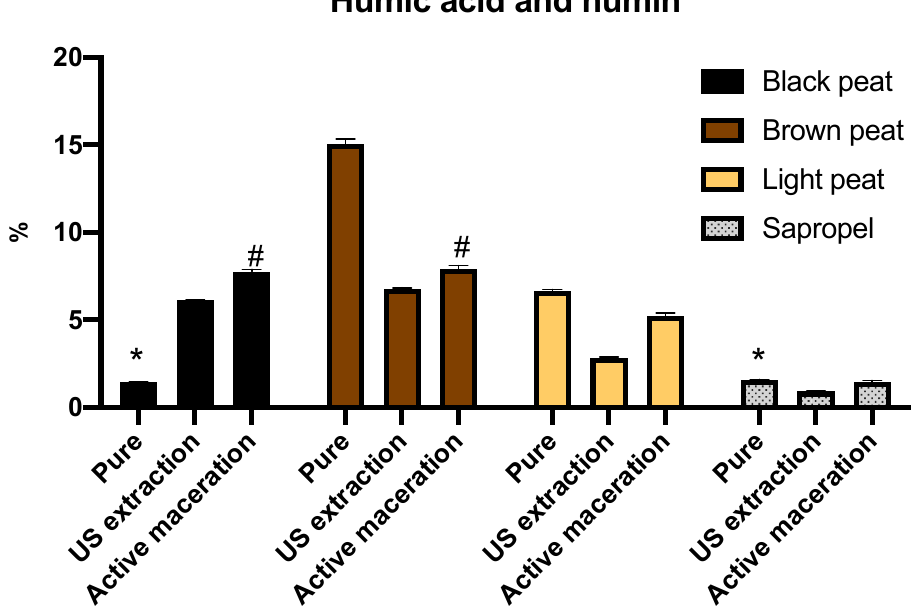
Figure 3. Humic acid and humin amount (percentage of total compound distribution) determined in the pure peat, in the extracts after ultrasound-assisted extraction and active maceration. *—Values with p = 0.1472; #—values with p = 0.5203; all other values with p < 0.05. The comparison of extract analysis showed higher amounts of humic acid and humin than of fulvic acid. Studies on particle size measurement of humic substances determined that humic particles were smaller that fulvic acid; the bigger diameters of submicron particles observed for fulvic acids in comparison with humic ones could be caused by higher amounts of ionizable functional groups, allowing for the greater expansion of fulvic coils in alkaline solution [31]. Such physical characteristics can influence higher extraction of humic acid, as shown by our results. The results of humic substance evaluation showed a positive correlation between the amount of fulvic acid and the amount of humic acid and humin r = 0.7541 ( p = 0.0046). Other researchers maintain that the ratio of fulvic to humic acid varies between soils and between horizons of the same soil. Humic fractions are involved with solubilization of the sesquioxide; therefore, additional steps of separation are recommended [25]. Results for humic substances determined in the pure peat, sapropel, and alkaline extracts were not consistent. Fulvic acid amount was higher in pure black and brown peat, and humic acid and humin amount was higher in pure brown and light peat in comparison with alkaline extracts. These variations demonstrate that the extraction procedures should be modified and optimized to achieve an expanded analysis of humic